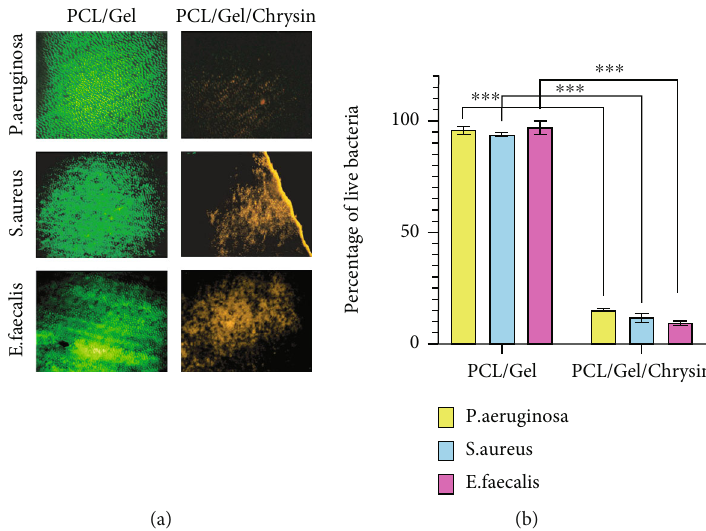
Figure 4: (a) Representative pictures of experimental groups showing live (green) and dead (red) cells of E. faecalis , S. aureus , and P. aeruginosa bacteria on dentin surface following PCL/Gel and PCL/Gel/Chrysin treatments. (b) Percentage of living bacterial cells after covering by PCL/Gel and PCL/Gel/Chrysin ( n = 6 ) ( ∗∗∗ p < 0 : 001